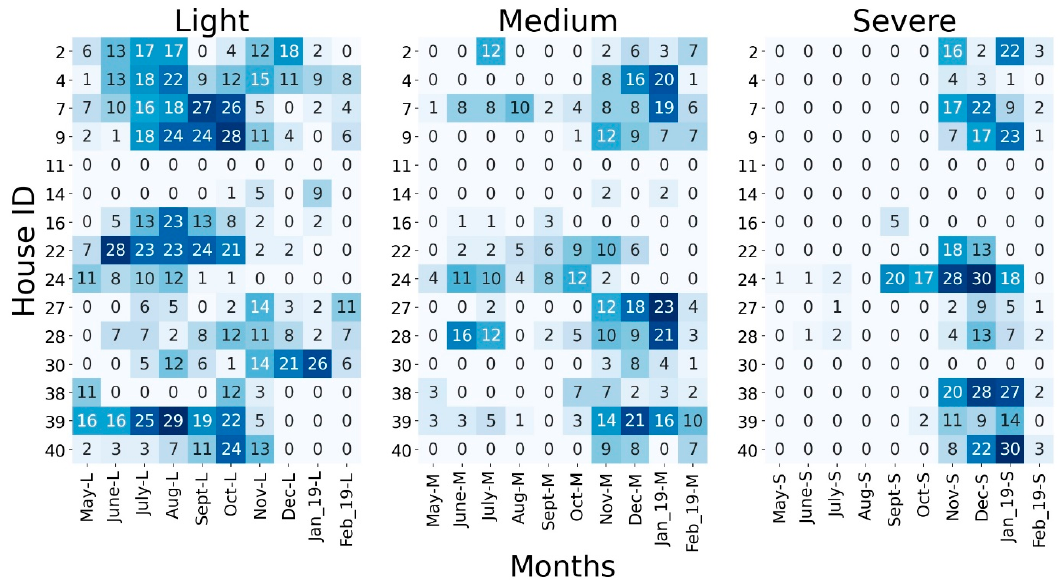
Figure 10. Number of underheating days per home split monthly according to criterion 2.